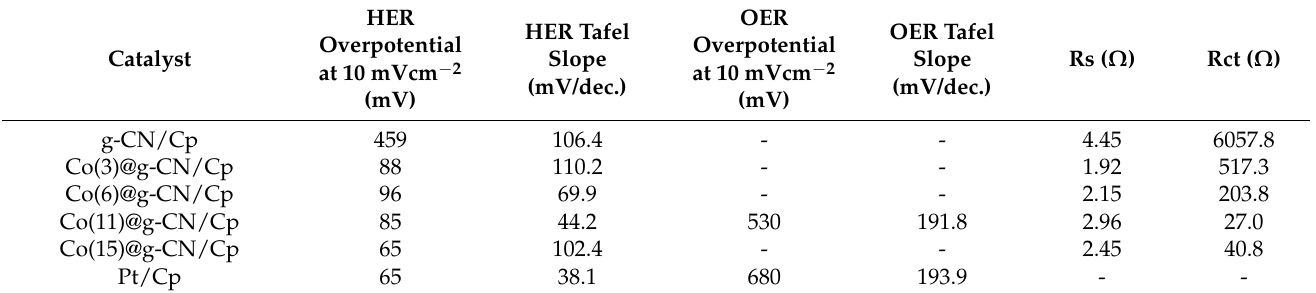
Table 2. Electrochemical parameters of different